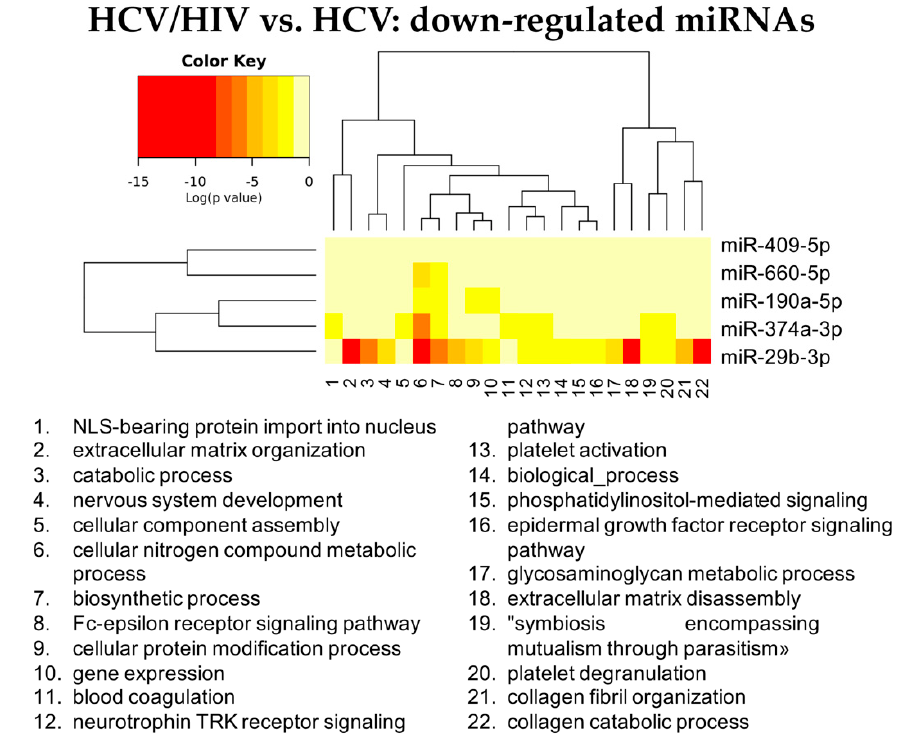
Figure 9. Heatmap showing the significance (see color key) of the association of down-regulated miRNAs with “Gene Ontology-Biological Process” categories, as identified applying the “Categories Union” method.